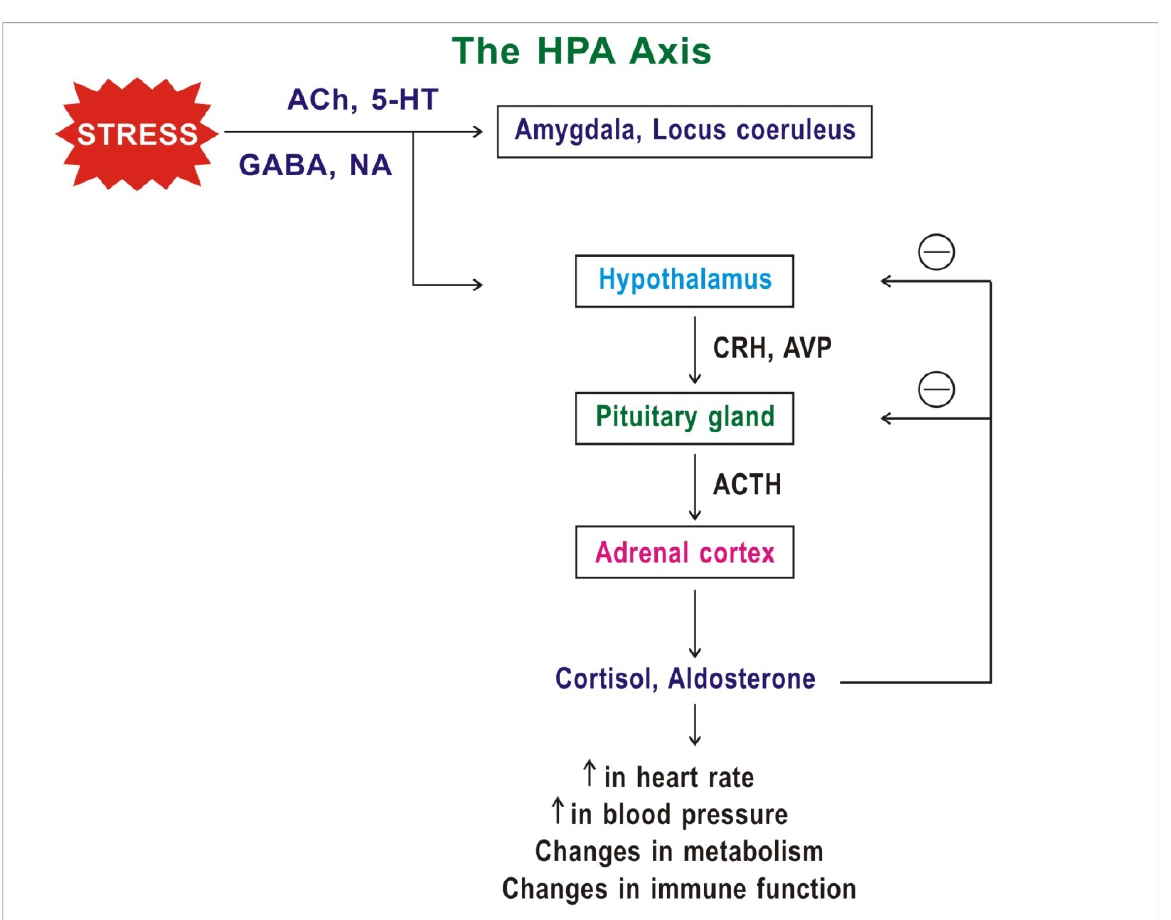
Figure 1. Diagram and simplified representation of the components of the hypothalamic–pituitary– adrenal (HPA) axis. Abbreviations: ACh: acetylcholine; ACTH: adrenocorticotropic hormone; AVP: arginine vasopressin; CRH: corticotropin-releasing hormone; GABA: gamma-aminobutyric acid; NA: noradrenaline.